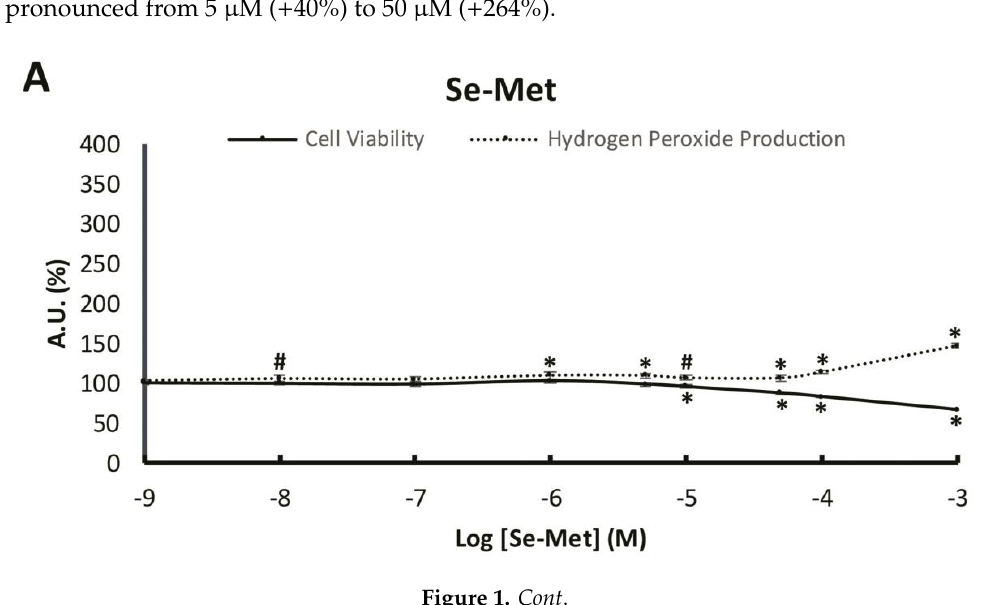
Figure 1. Cell viability and hydrogen peroxide production in MCF-7 breast cancer cells after selenomethionine or selenocystine treatment. ( A ) The cells were treated with vehicle or with increasing concentrations of selenomethionine (from 1 nM to 1 mM) for 48h. ( B ) The cells were treated with vehicle (data not shown) or with increasing concentrations of selenocystine (from 100 pM to 50 µM) for 48h. Solid line represents the cell viability and pointed line represents hydrogen peroxide production. Points in lines represent means and error bars represent SEM ( n = 6). The value of control cells was set at 100% (data not shown) and the rest of values were calculated referenced to the control set at 100%. * Significant differences between selenoamino acid treated and control cells (Student’s t-test; p ≤ 0.05). # Significant differences between selenoamino acid treated and control cells (Student’s t-test; p ≤ 0.1). AU: Arbitrary Units. 3.2. Effects of Selenoamino Acids on Antioxidant Enzymes and UCP2 Protein Levels For the analysis of the antioxidant enzymes and UCP2 protein levels, we chose two concentrations of each Se-aminoacid, 10 nM and 10 µM, representative of the results obtained in the cell viability and H 2 O 2 production analysis. Figure 2 displays the results obtained in the protein